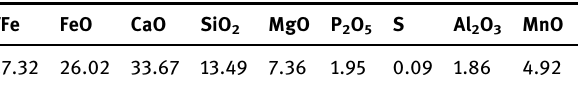
Table 2: Main chemical composition of Baogang steelmaking slag wt%